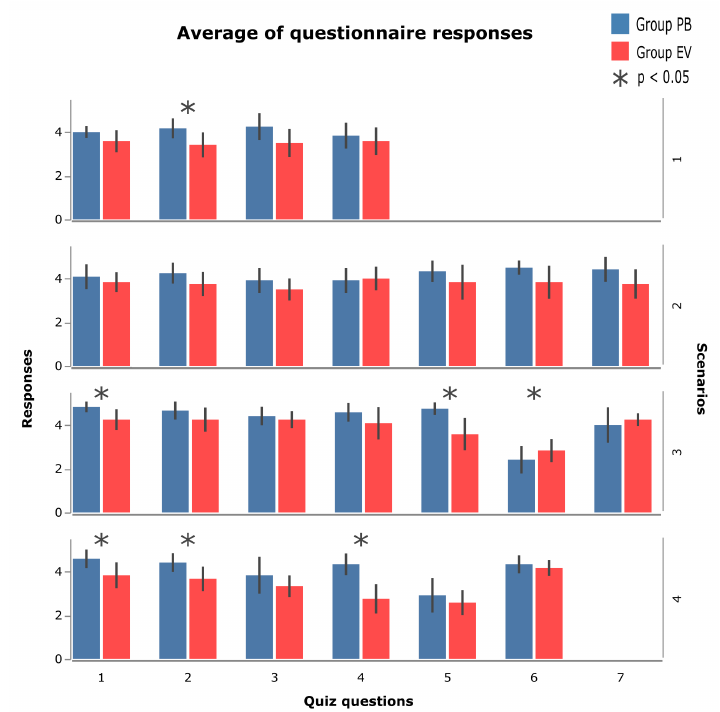
Figure 21. Average of all questionnaire